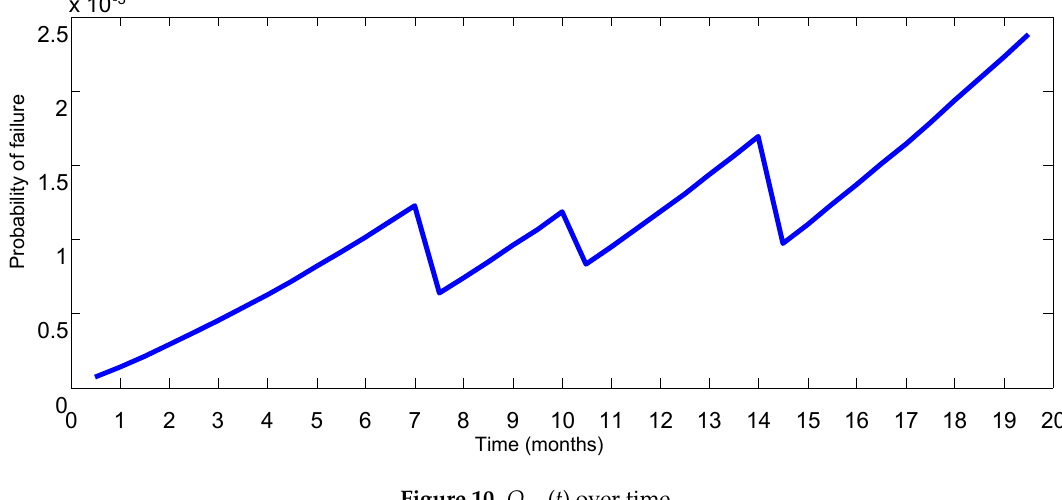
Figure 10. Q sys ( t ) over time.